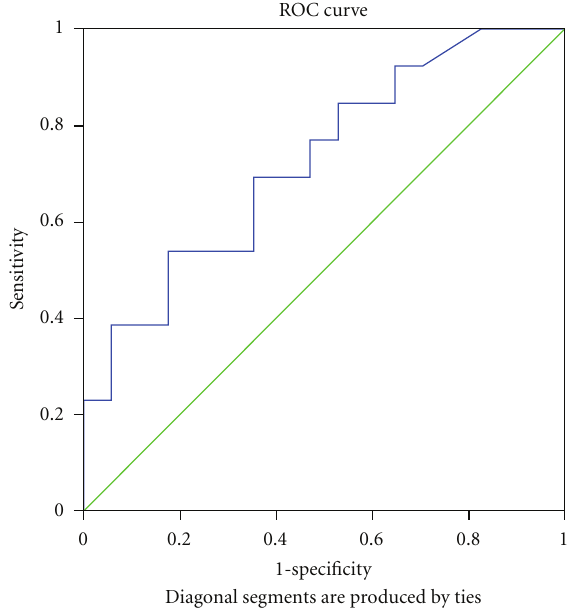
Figure 2: ROC curve—OPP at 18-month visit in progressing glaucoma patients. ROC: Receiver operating characteristic.